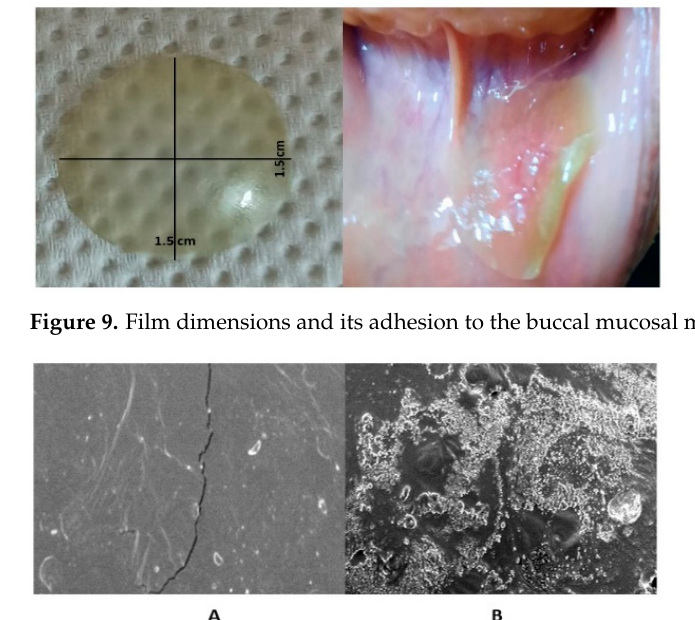
Figure 10. Scanning electron microscopic of the plain film ( A ), and drug-loaded film ( B ).